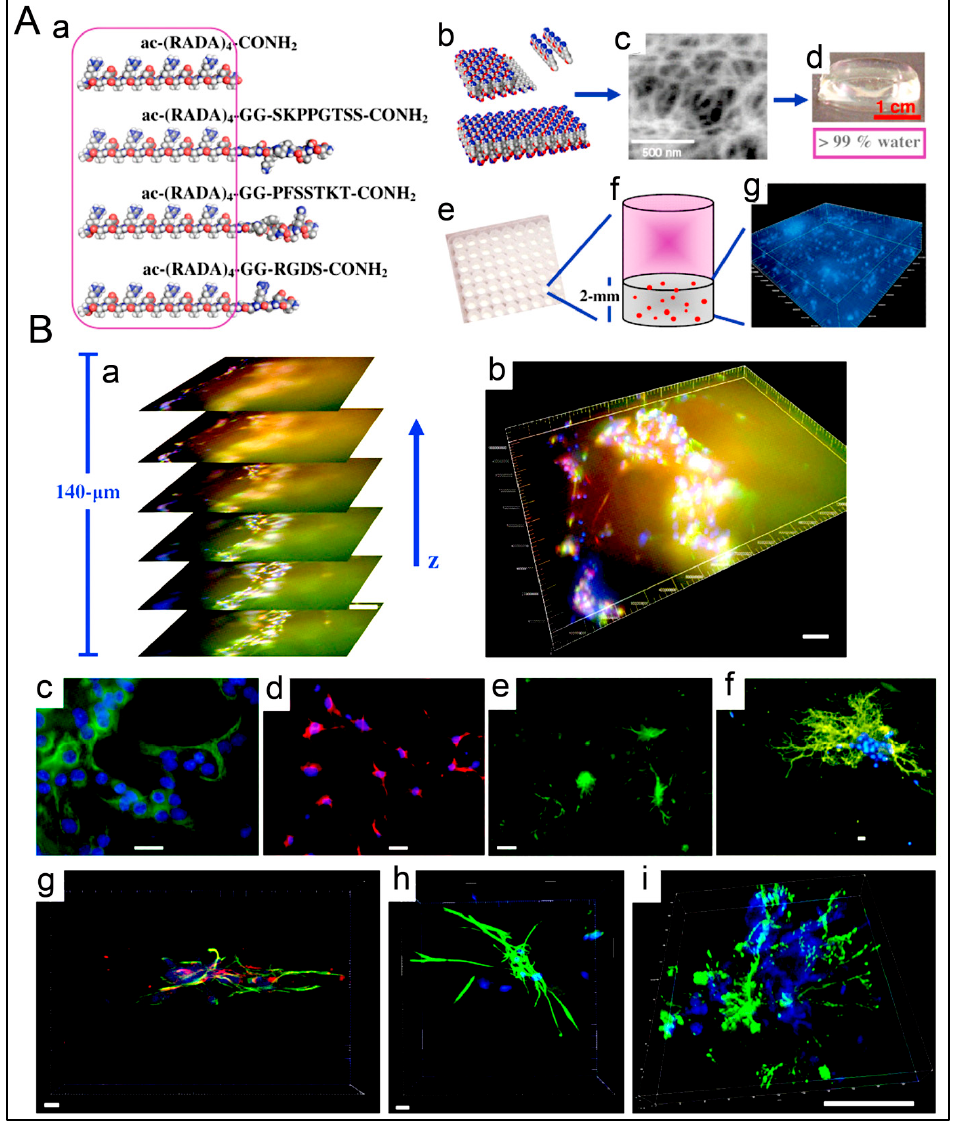
Figure 11. Three-dimensional NSC cultures in peptide hydrogels, Matrigel and Collagen I. ( A ) ( a ): Molecular structures of ac-(RADA 4 -CONH 2 and modified peptides with di-glycine linker